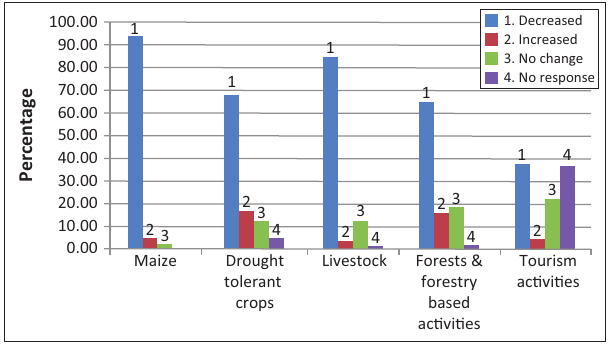
FIGURE 2: Perceptions of impacts of changes in climate on agriculture and tourism